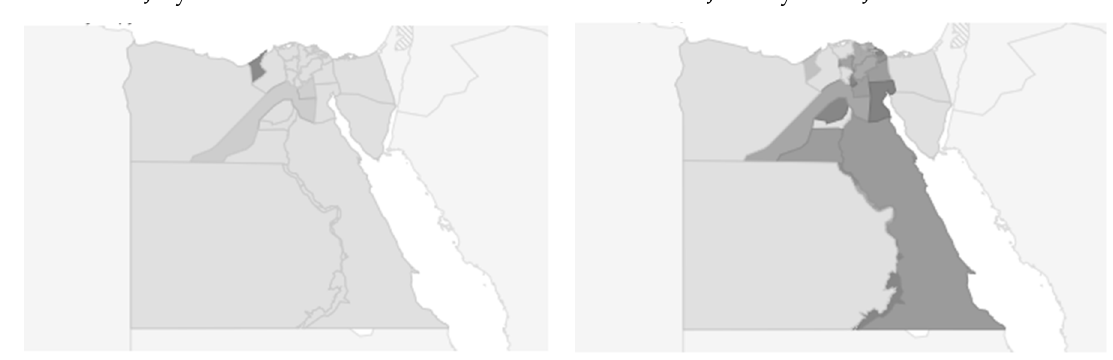
Figure 1. The dynamics of Google’s search queries in Egypt for the word “porno” (by province) *. * The darkest coloring corresponds with the highest number of requests. Source: (Google Trends 2018).